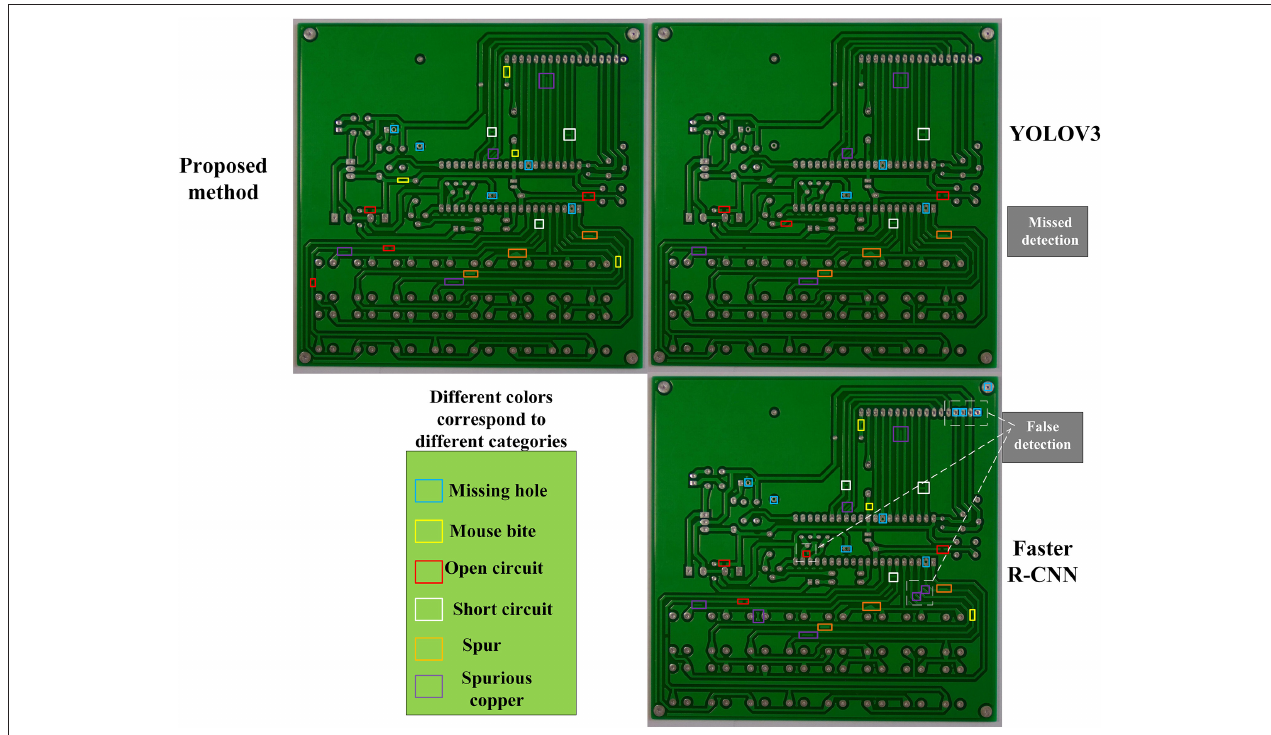
FIGURE 9 | The comparison diagram of PCB identification effects of different